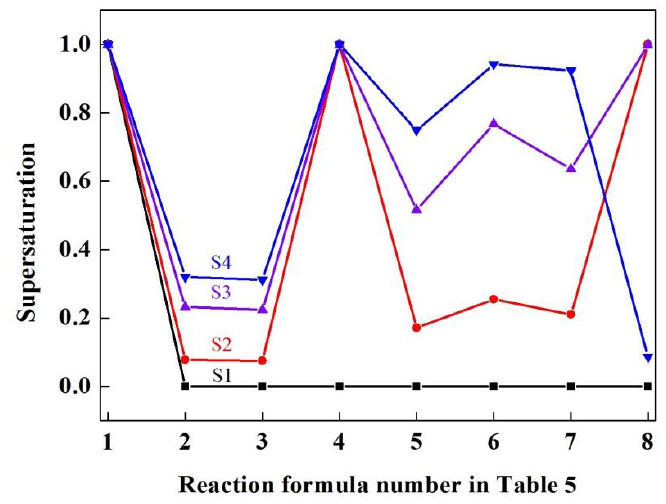
Figure 5. Comparison chart of activity product and equilibrium activity product of different reaction formulas at 1873 K.